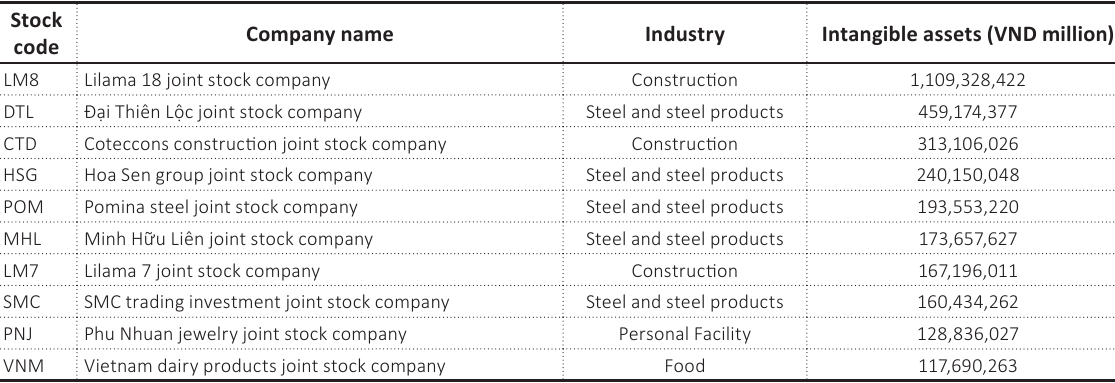
Table 4. Top 10 Vietnamese firms by intangible asset value, 2014